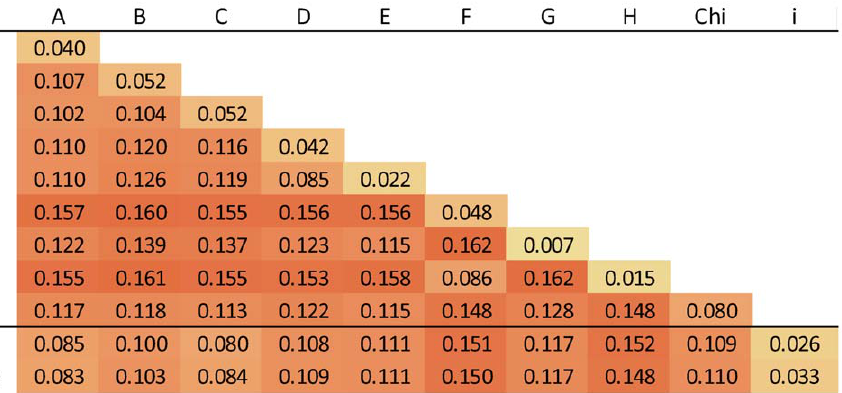
Figure 2. Mean distances between full-length sequence of genotype A-H, genotype chimpanzee (Chi) and genotype I, generated by MEGA4 package. Values on the diagonal are the mean distances within each genotype. The calculation is based on the Maximum Composite Likelihood distance correction method.